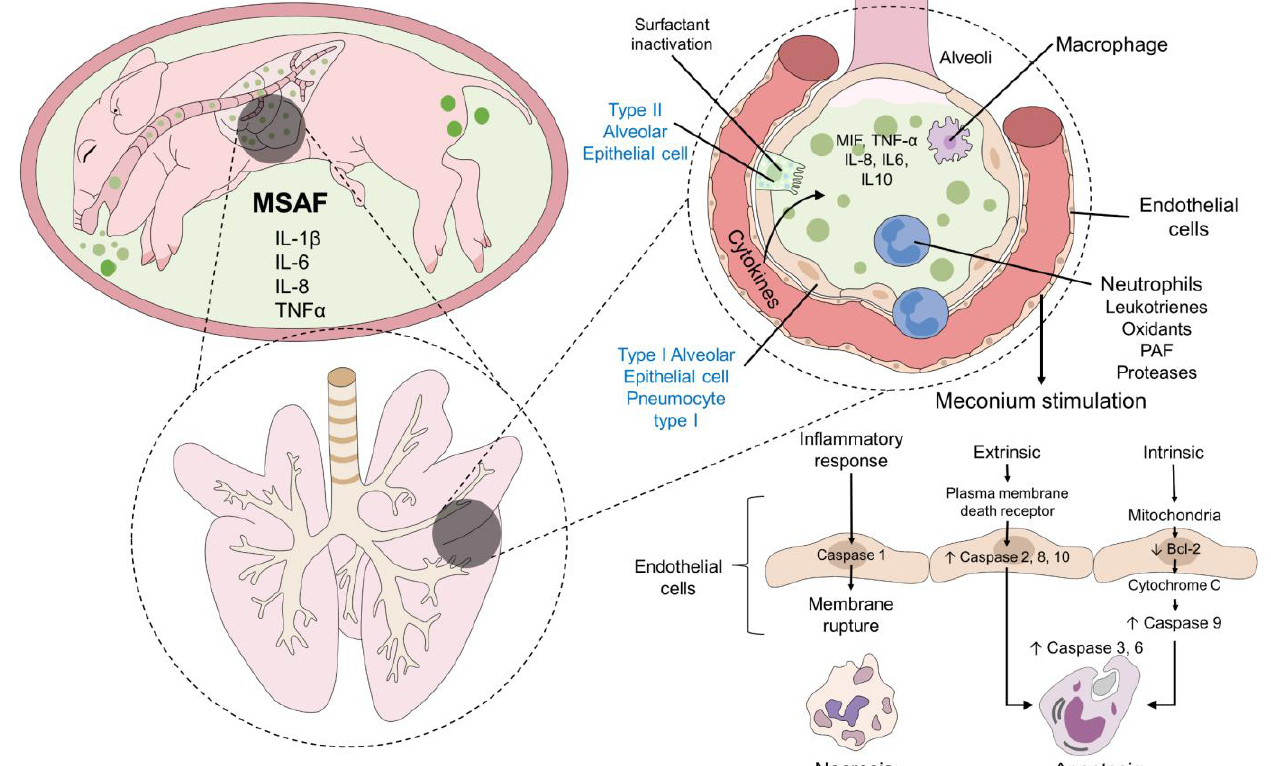
Figure 4. Apoptosis process after meconium aspiration. Derived from the inflammatory process in the lungs and, specifically, in the alveoli, the presence of cytokines, neutrophils, and macrophages evoke the endothelial cells of the alveoli to induce meconium stimulation which can result in three different pathways. The inflammatory response is associated with necrosis of the cells by the intervention of caspase 1. The extrinsic pathway involves the plasma membrane death receptor and the presence of caspase 2, 8, and 10, while caspase 9, together with cytochrome C and Bcl-2, participate in the intrinsic pathway to cause apoptosis of the endothelial cells. Bcl2: b cell lymphoma-2; IL: interleukin; MIF: macrophage migration inhibitory factor; TNF- α: tumor necrosis factor -alpha.